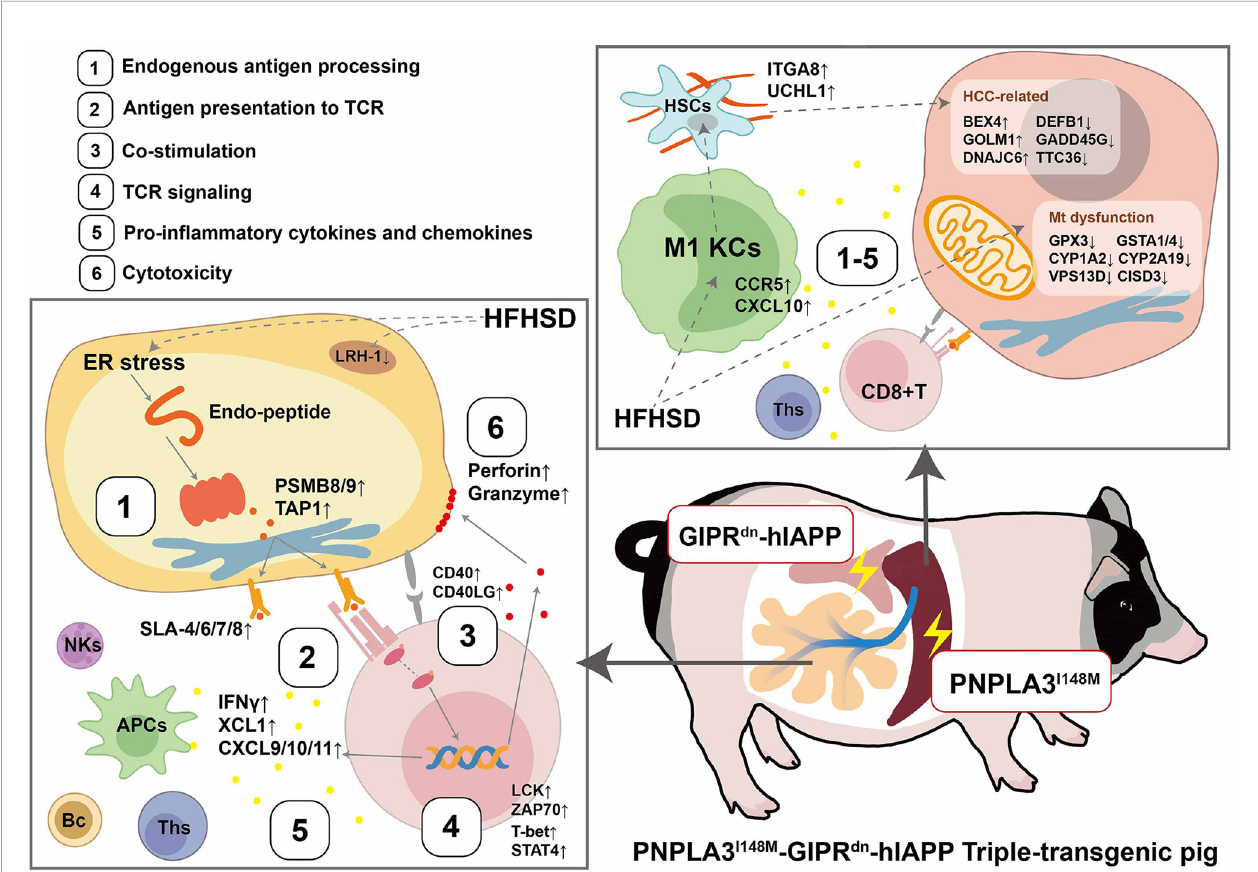
FIGURE 6 | Landscape of CD8+ T cells involving in meta fl ammation in VAT and liver of transgenic pigs. Stressed adipocytes suffered from fuel overload, generated changed endogenous antigens, and present them through MHC-I complex (1). TCR complex on CD8 + T cells recognizes MHC-I antigen (2). In company with co- stimulation (3), down-stream signal was activated (4), a series of pro-in fl ammatory cytokines and chemokines, including IFN g were released by CD8 + T cells (5), recruiting antigen-presenting cells (APCs) and CD4 + T helper cells (Th1). Meanwhile, effector CD8 + T cell secret cytotoxic molecules, including perforin and granzyme, inducing cytotoxic effects (6). Liver metabolic homeostasis was undermined by PNPLA3 I148M expression and over-nutrient. In fl ammatory components that originated from visceral adipose tissue may mediate the crosstalk with the liver via blood circulation, and then trigger liver meta fl